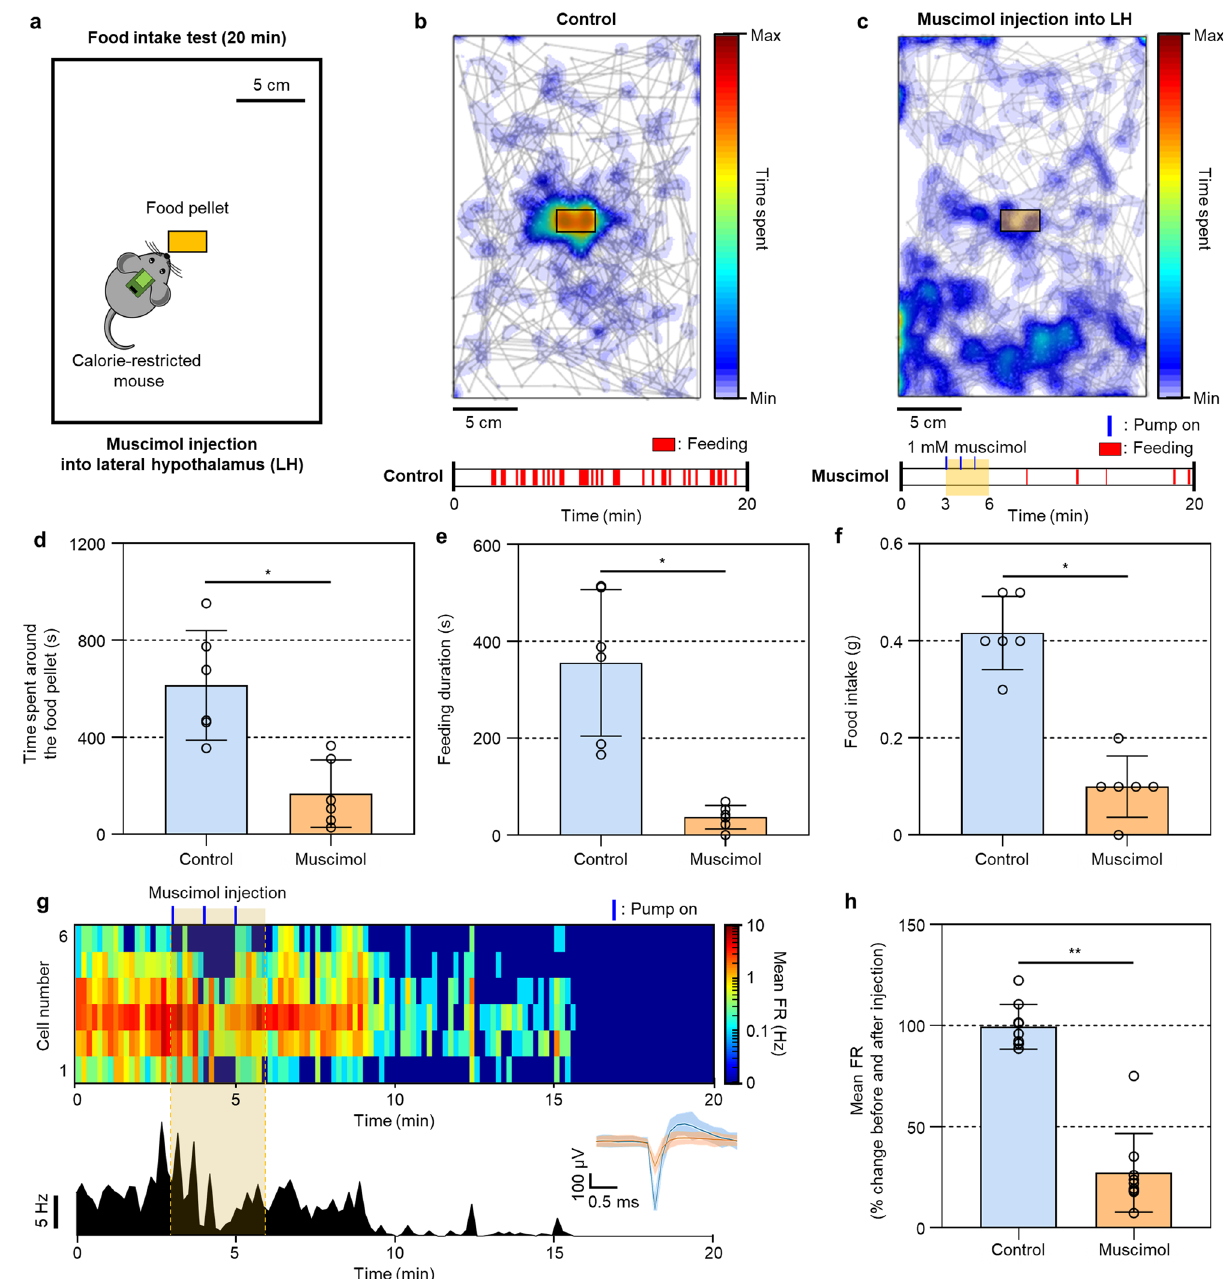
Fig.5|Modulationoffeedingbydrugdeliveryandsimultaneousmonitoringof neuralchanges. a Schematicillustration showing the experimentalsetup for food intaketest. b , c Behaviorheatmapexpressedbasedonnosepositionsin b acontrol experimentand c muscimol-injected experiment.Theblue lineabovethe